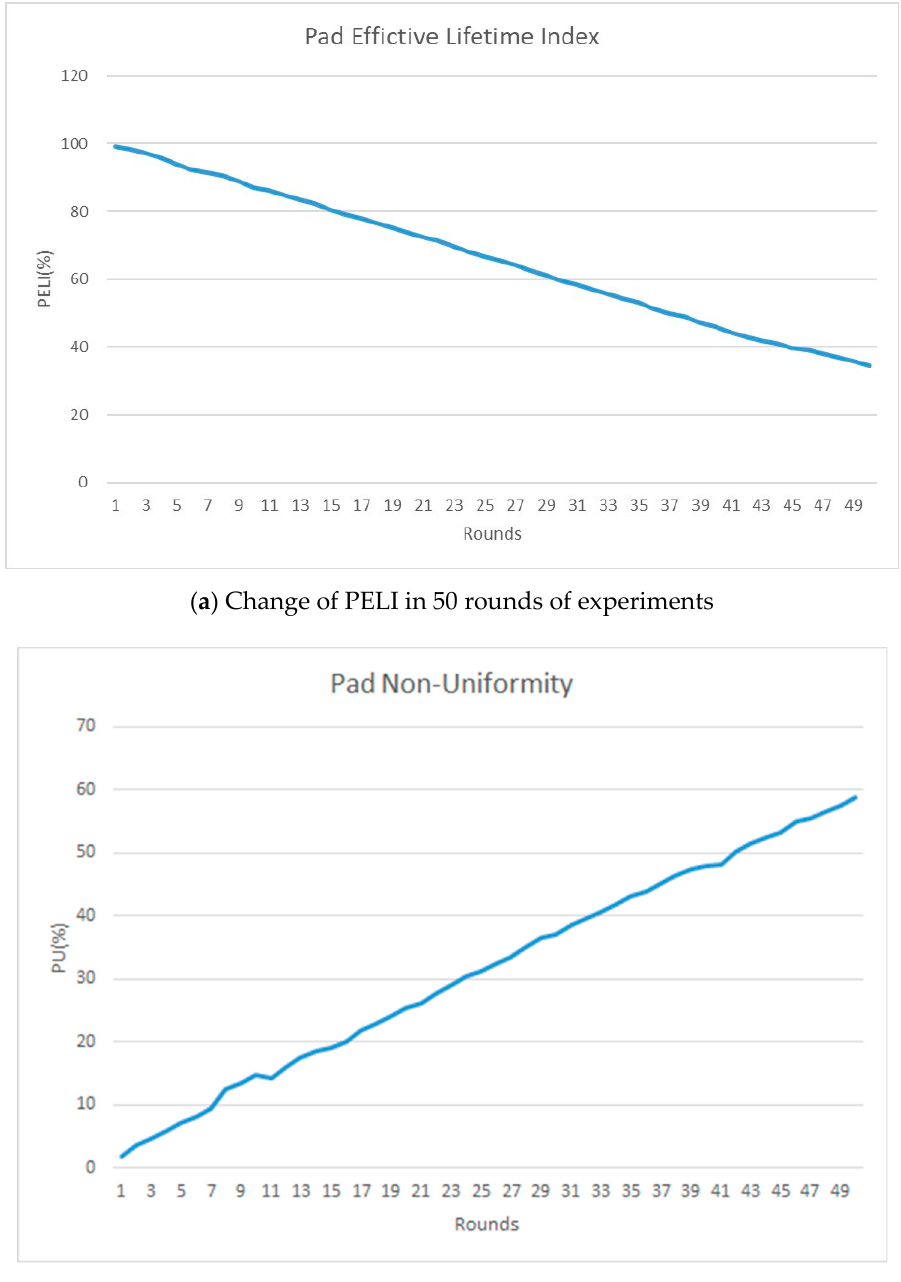
Figure 9. Results of PELI and PU for 50 rounds of CMP experiments.